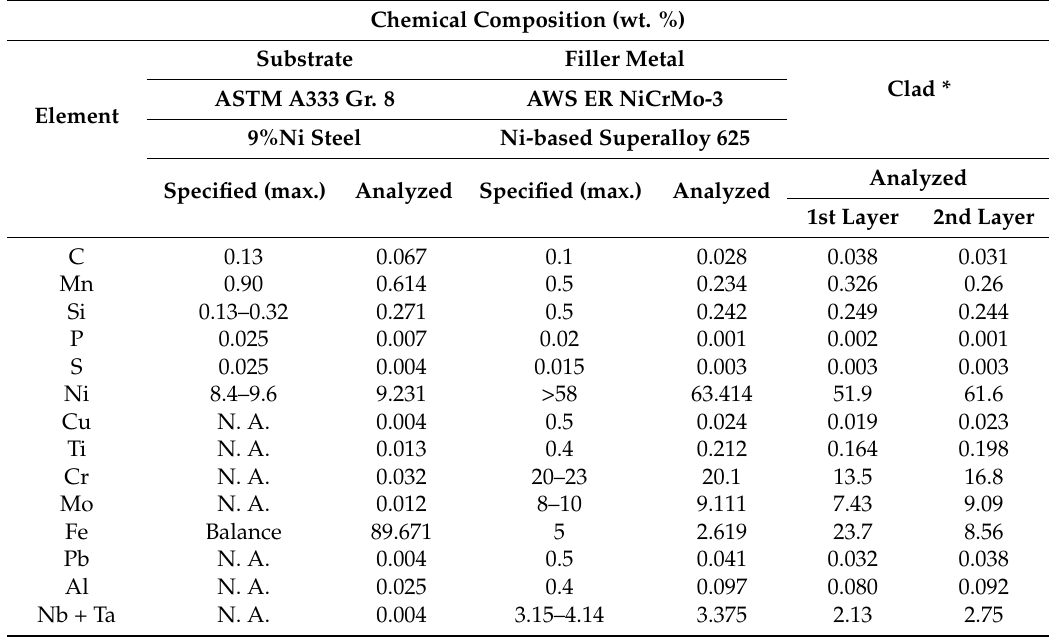
Where: N. A. means not applicable. * The chemical composition of clad I is the same as that of the first layer of clad II.